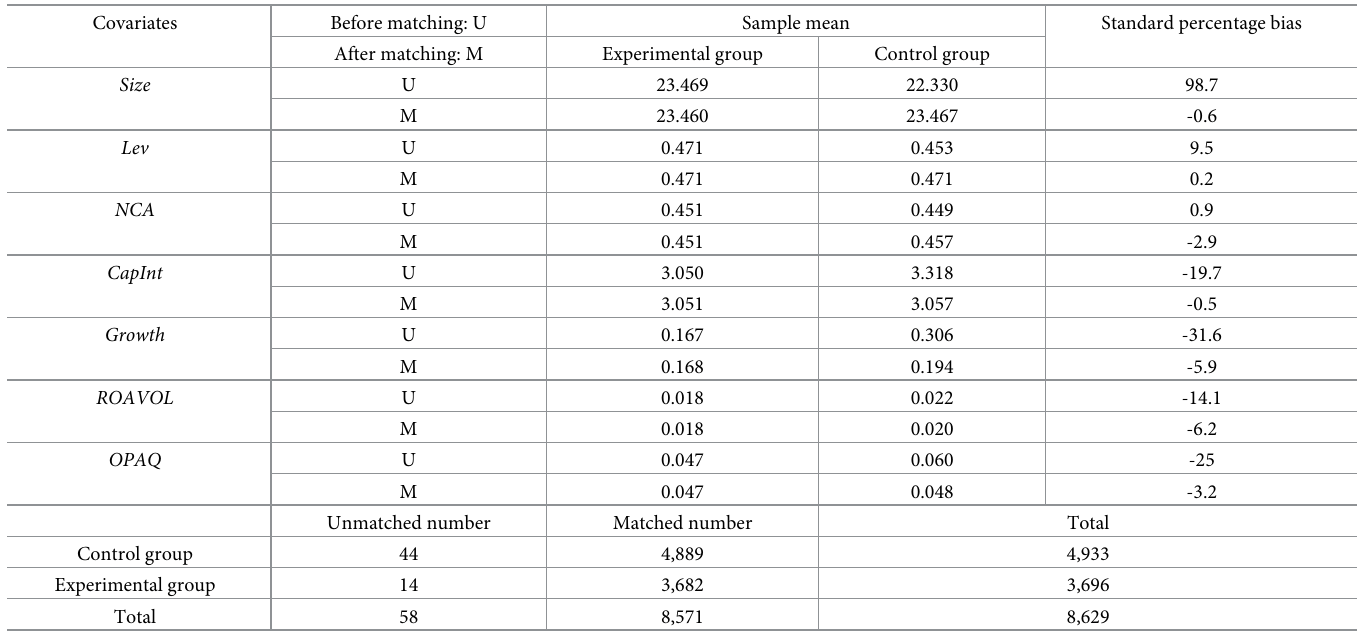
Table 5. PSM results. Covariates Before matching: